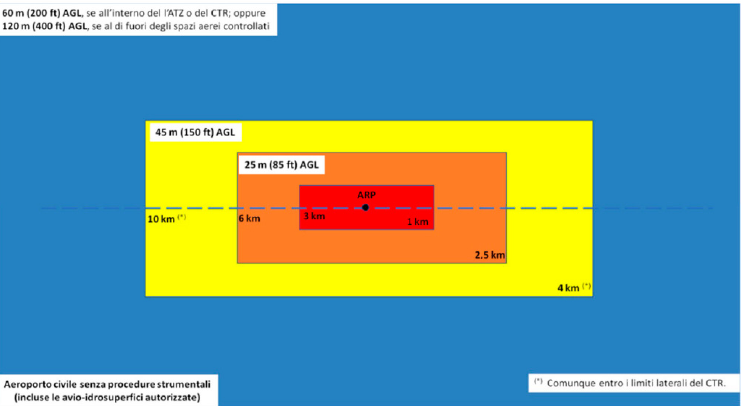
Figure 9. Maximum UAV flight height for a civil airport without instrumental procedures (ATM09